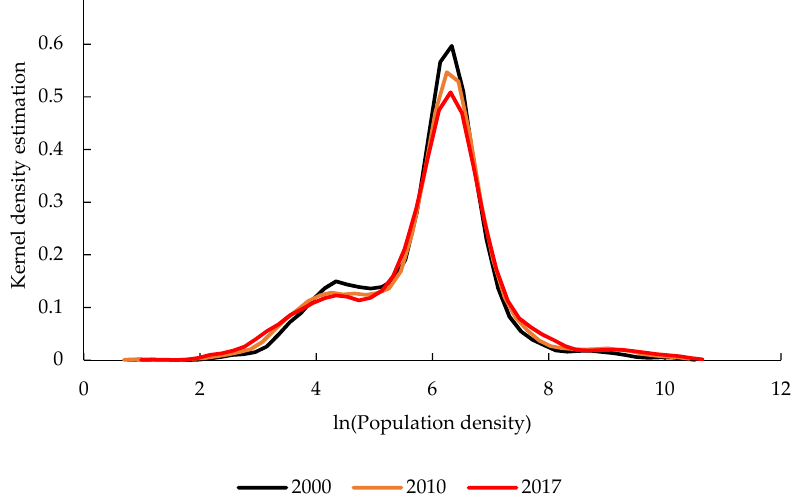
Figure 2. Log kernel density estimation of population density in the Beijing–Tianjin–Hebei region from 2000 to 2017.